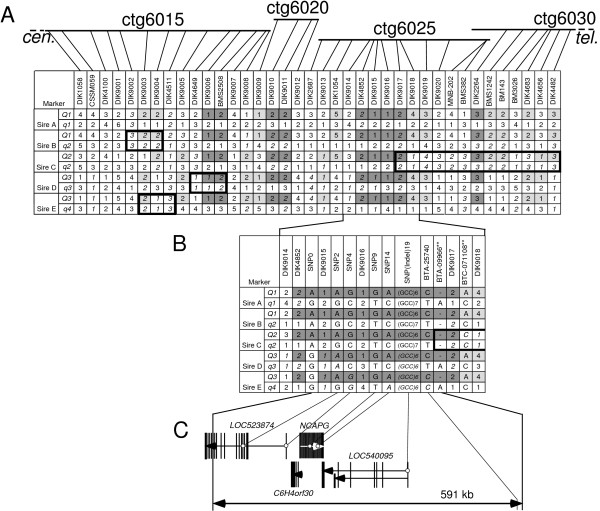
Haplotype comparison in the CW-2 region. The alleles shared among two or three Q haplotypes are colored light grey or grey, respectively. The alleles homozygous in a sire are shown in italics. The regions homozygous for more than two consecutive markers are boxed. (A) Haplotypes between 38 and 55 cM. Locations of the microsatellite markers in the BAC fingerprint map are shown [27]. (B) Haplotypes around the critical 591-kb region. (C) Genes located in the 591-kb region. Exons are indicated by the vertical lines. Each arrow shows the location and direction of a transcript.